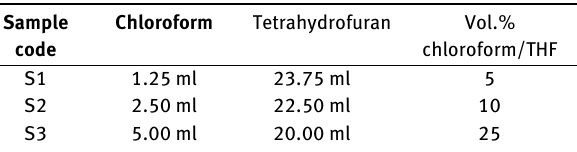
Table 1: Samples code and solvent volumetric ratios used in sample preparation